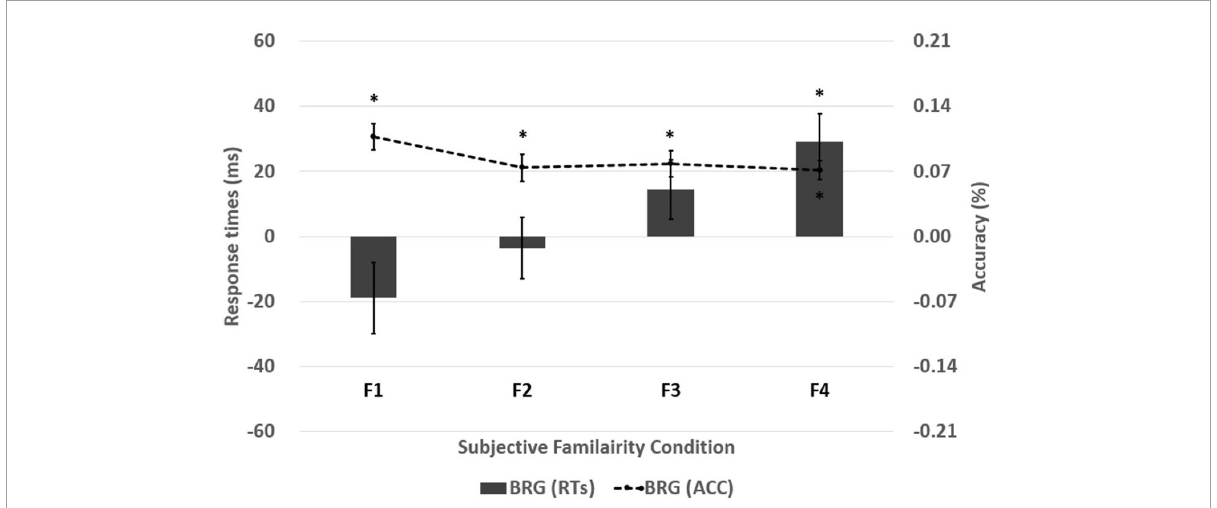
FIGURE4 The BRGs were obtained from the four subjective familiarity levels. The four subjective familiarity levels indicate F1 ( M = 4.21, SD = 0.74), F2 ( M = 4.61, SD = 0.91), F3 ( M = 5.10, SD = 0.75), and F4 ( M = 5.46, SD = 0.78). The line in the bar graph denotes the range of standard error. The asterisk indicates the significance of effect in one-sample t -test in response times and accuracy (* p < 0.05).